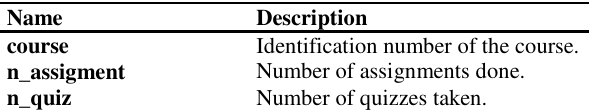
Table 1: Description of data used in experiments for each user per